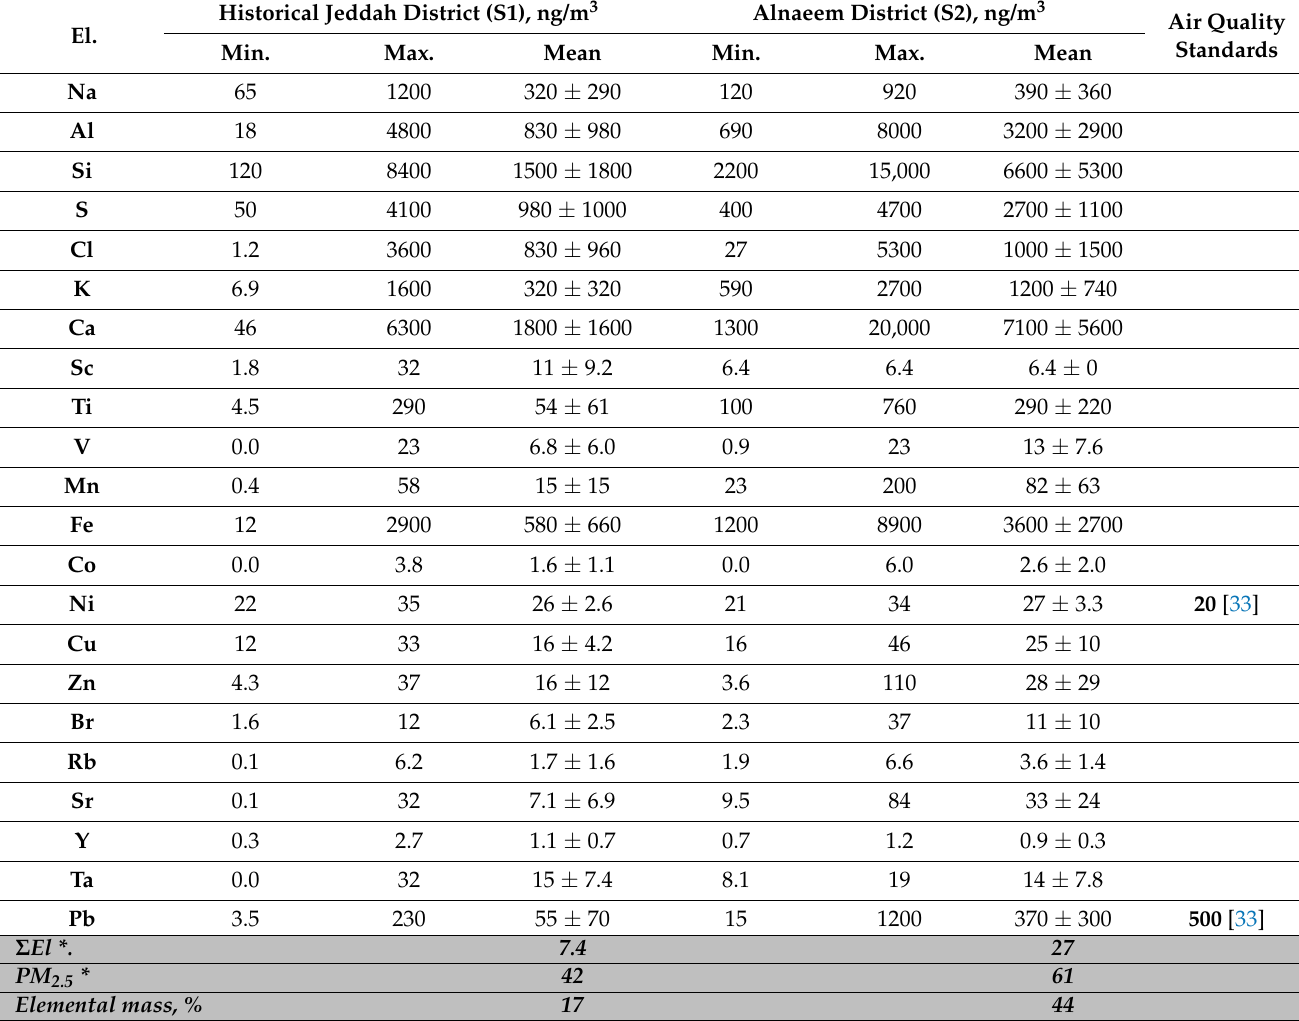
Table 2. The minimum, maximum and the mean values of the elemental analysis in the PM 2.5 assembled from historical Jeddah and Alnaeem